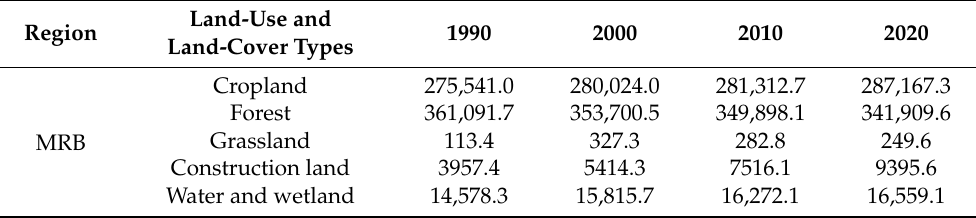
Table A1. Area (km 2 ) of land use in the Mekong River Basin (MRB) from 1990 to 2020.